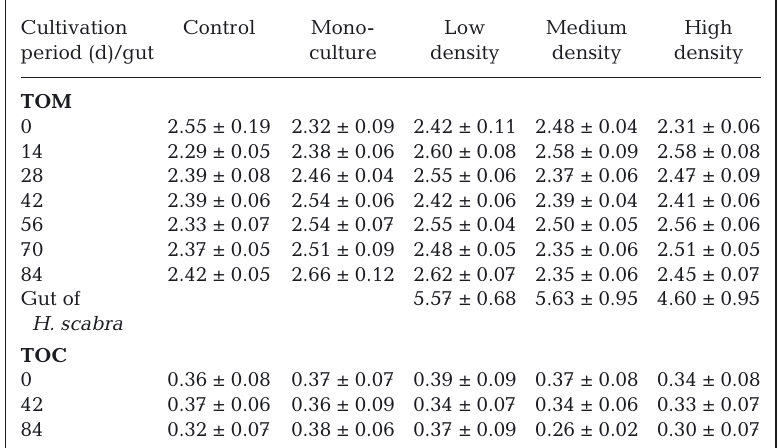
Table 1. Total organic matter (TOM) and total organic carbon (TOC) contents in integrated mariculture. TOM in the sediment and the gut of the co-cultured sea cucumber Holothuria scabra during the cultivation period of seaweed Eucheuma denticulatum at different stocking densities of H. scabra (see Table 2). Control: procedural control without seaweed and sea cucumbers. TOC in sediments across treatments before stocking the cages, after 42 d and at the end of the cultivation period. Mean ± SD (% dry